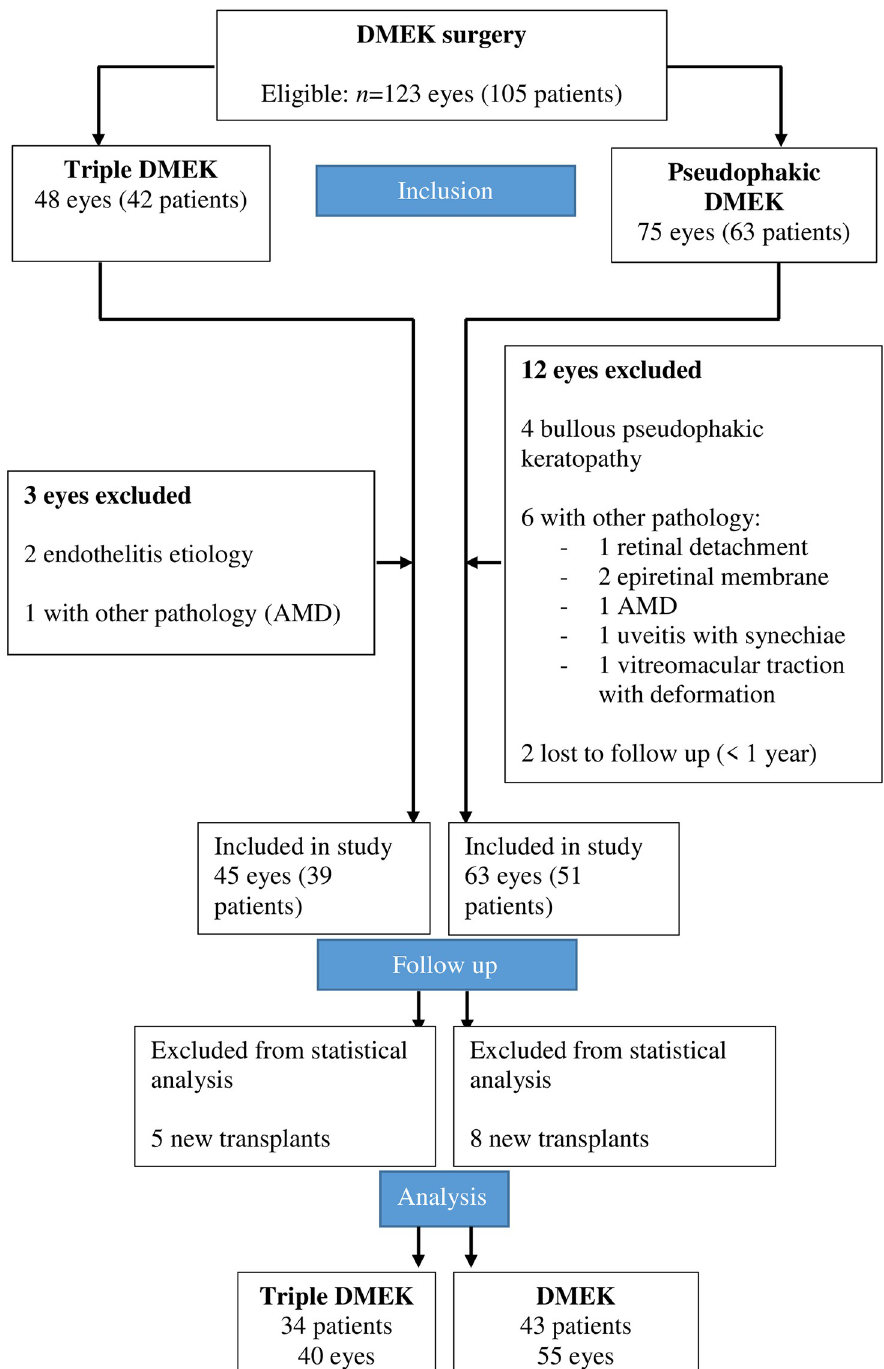
Fig 1. Flow chart depicting the disposition of the subjects during the study. AMD, age-related macular degeneration; DMEK, Descemet membrane endothelial keratoplasty.